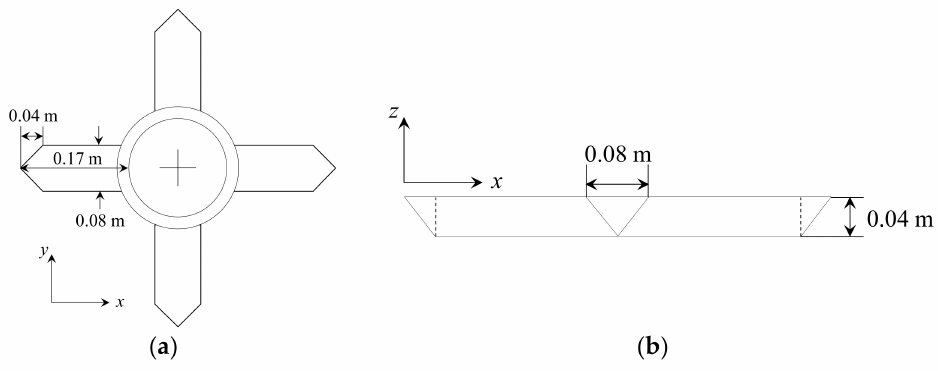
Figure 4. Shape of the floating anti-vortex device (F-AVD): ( a ) plan view and ( b ) side